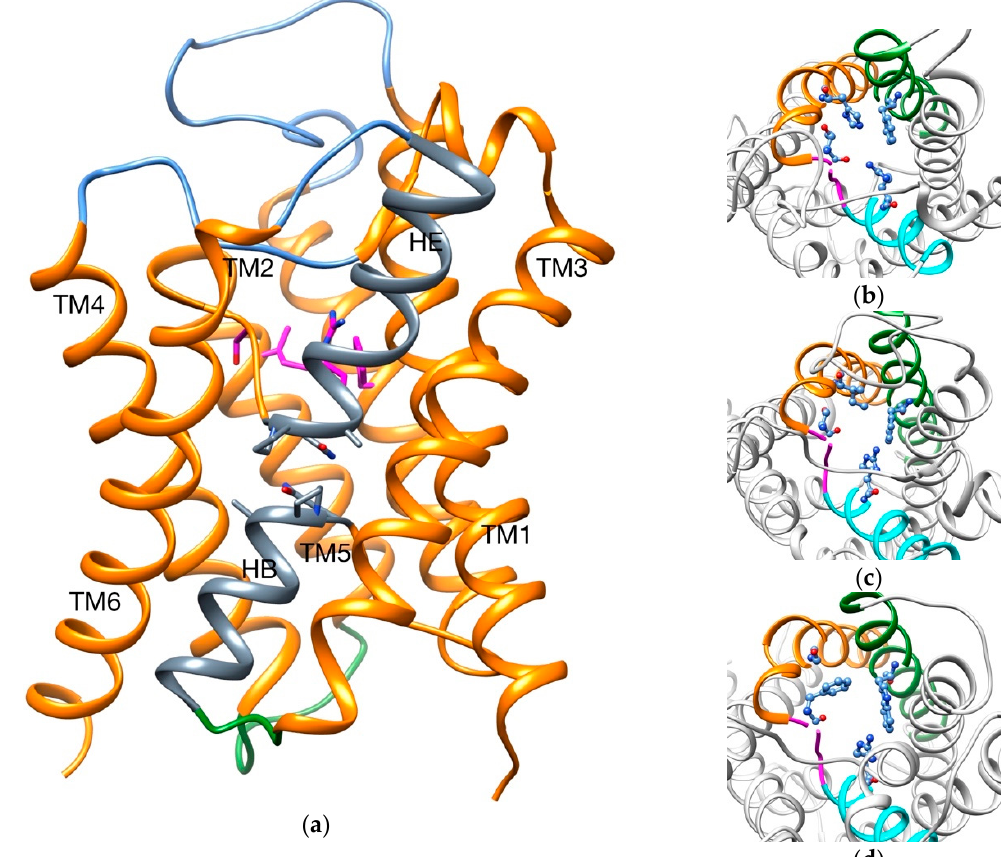
Figure 1. ( a ) Overall structure of an aquaporin. Extracellular loops are colored in blue, intracellular loops in green and the two hemihelices (HB and HE) in gray; SF is highlighted in magenta sticks and Asn-Pro-Ala motifs in gray sticks. In lateral panels, SF for different AQPs are shown: ( b ) AqpZ; ( c ) AqpM; ( d ) GlpF. TM2 is colored in green, TM5 in orange, HE in cyan and TM5-HE loop in magenta; SFs are highlighted in blue balls and sticks.